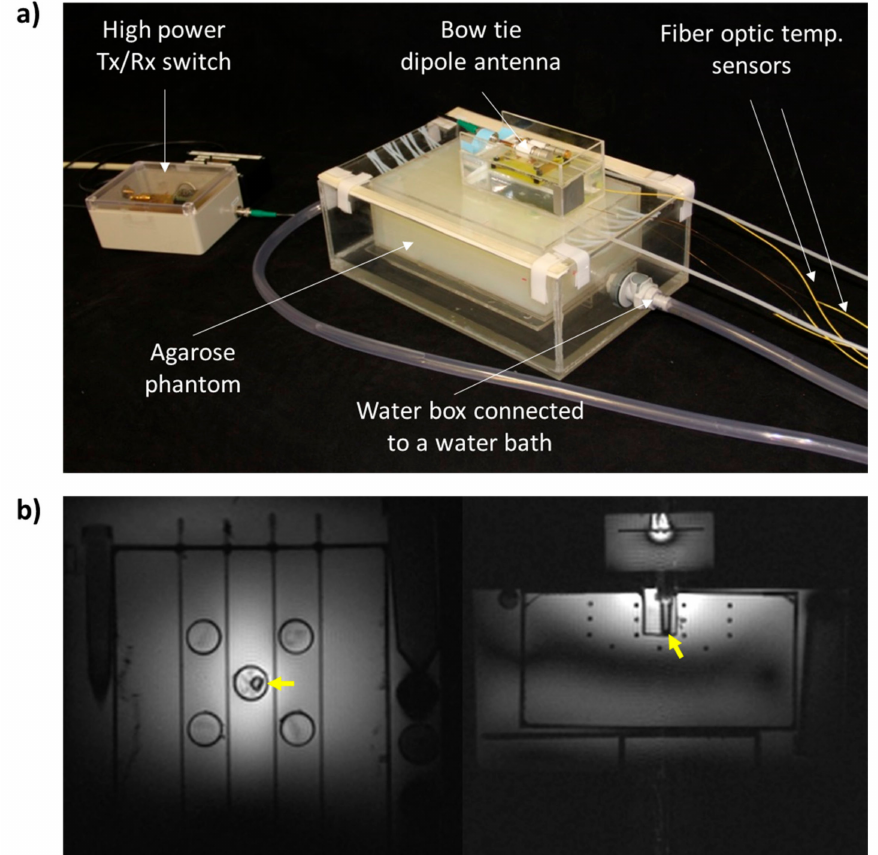
Figure 7. ( a ) Photograph of the experimental setup at the MR system; the agarose gel phantom for holding the Vivaspin filter with the BSA-FITC-loaded nanogels, the water box connected to a water bath for background temperature modification (in this case 37 ◦ C), a bow tie dipole RF antenna for imaging and RF heating, a customized high-power Tx / Rx switch and fiber optic temperature sensors as temperature reference for MR thermometry. ( b ) MR images of the phantom. The Vivaspin tube with the nanogel sample in the middle sample holder (heated sample) is indicated by the yellow arrows. Left: axial view at a depth of 15 mm (at the level of the second row of the PTFE tubes). Right: axial view at the center of the middle sample